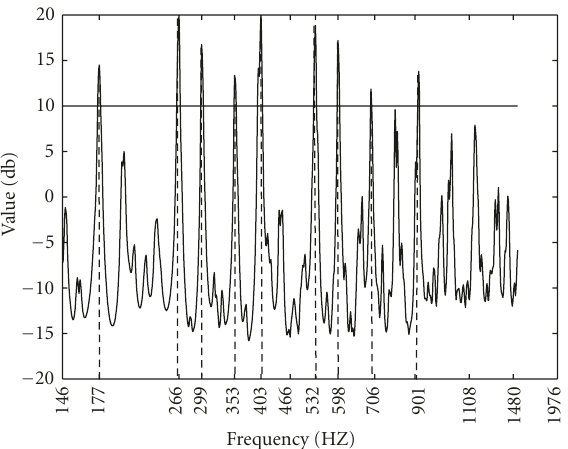
Figure 4: Relative Pitch Energy Spectrum of a violin example con- sisting of four concurrent notes with the fundamental frequencies 266 Hz, 299 Hz, 353 Hz, and 403